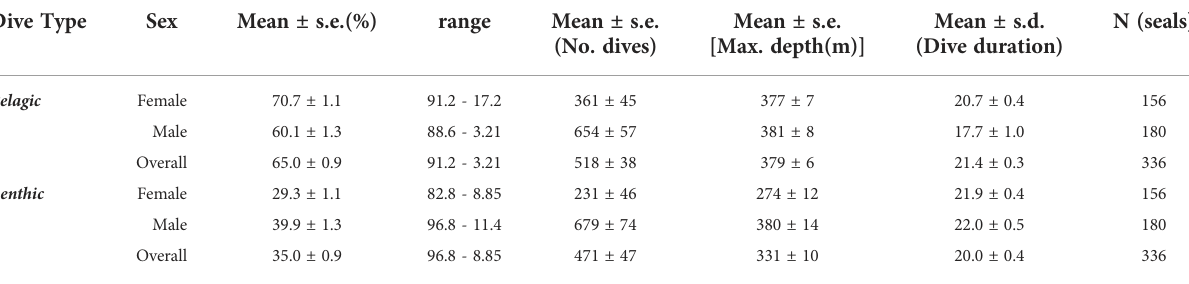
TABLE 1 Summary statistics of two types of foraging behaviour (benthic and pelagic) performed by adult female and sub-adult males on the Kerguelen Plateau.